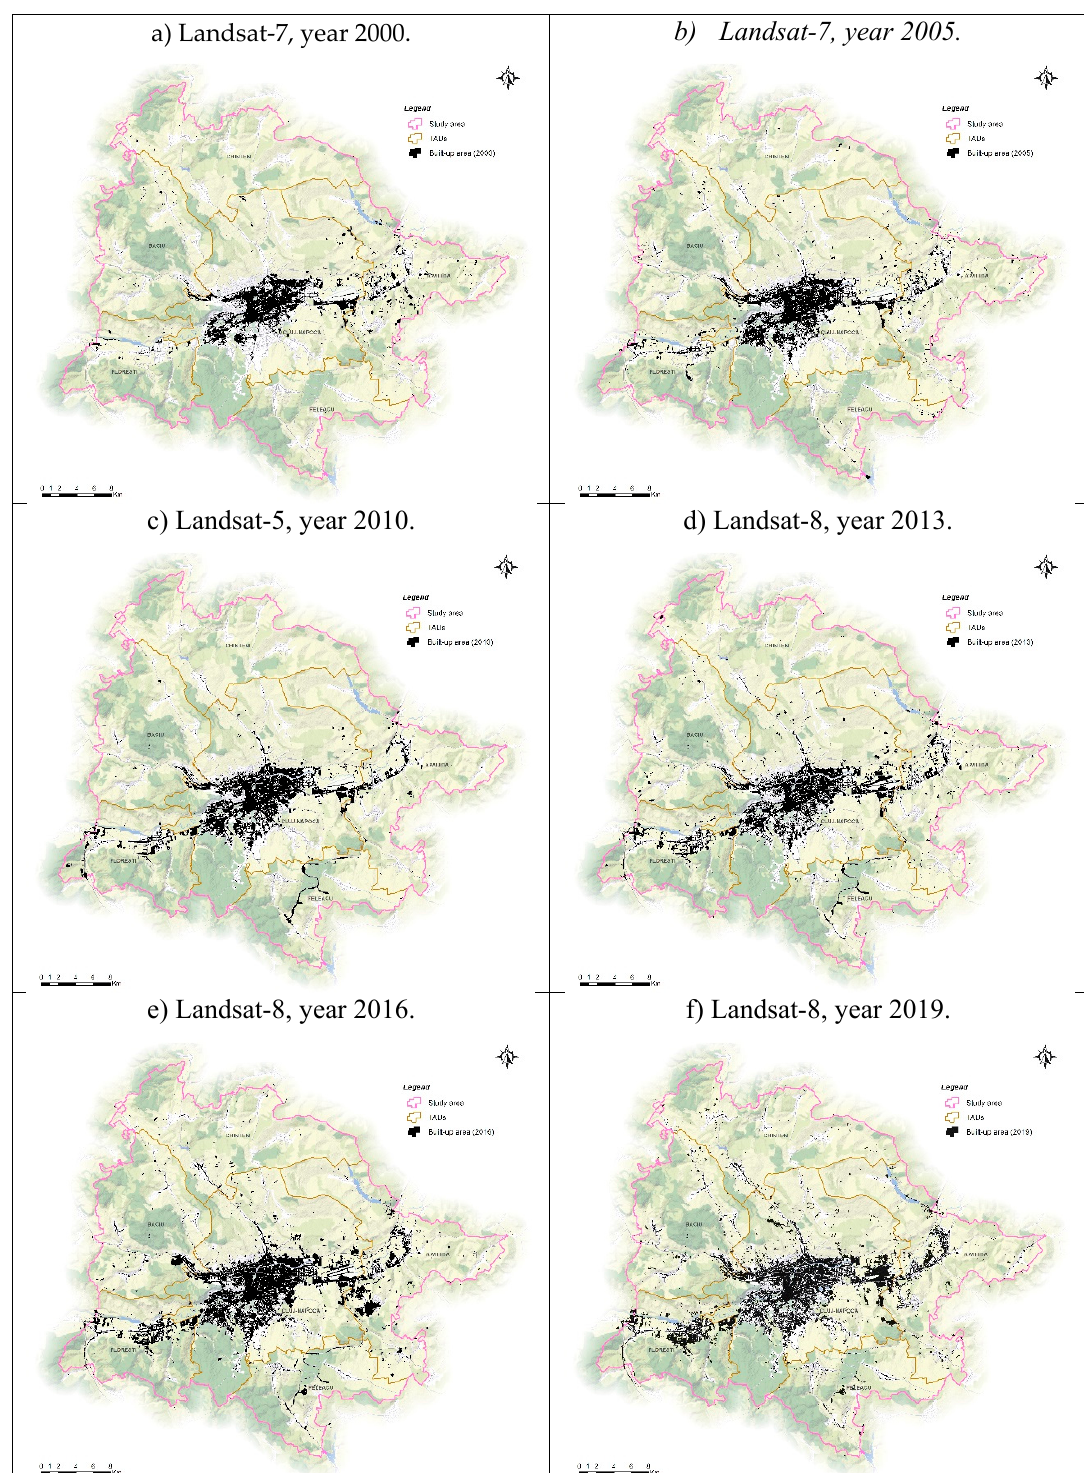
Figure 3. Results of the analysis based on proposed method.